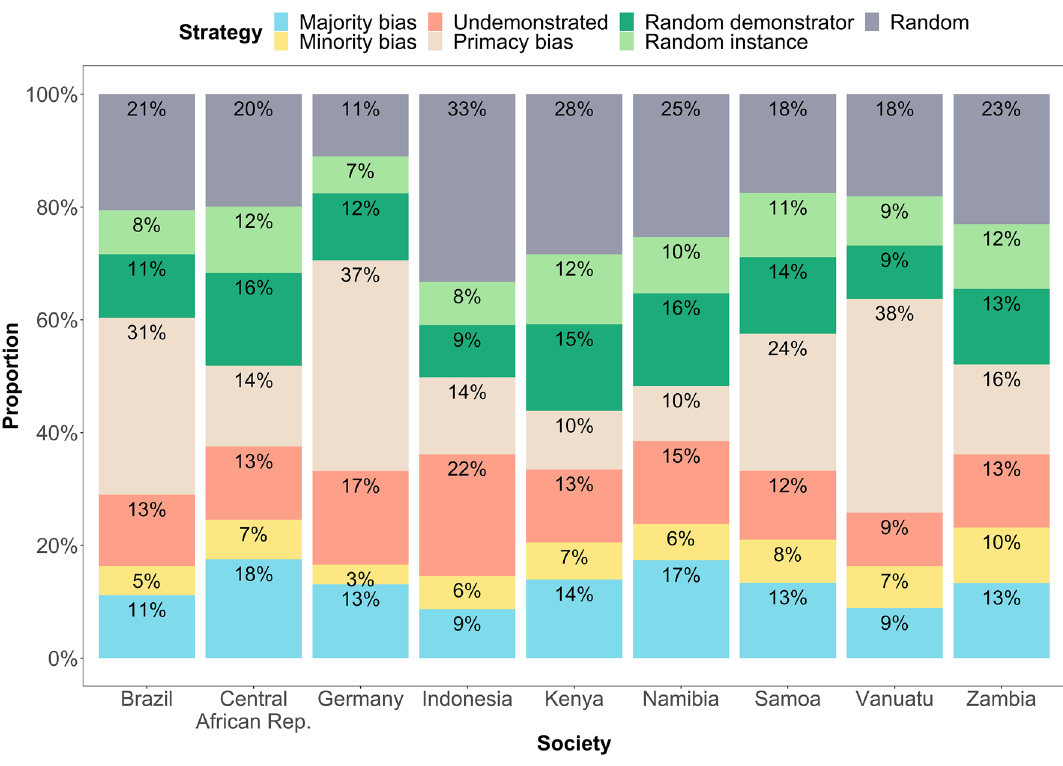
Figure 5. Inferred posterior mean probabilities of the seven selected learning strategies by society averaged over